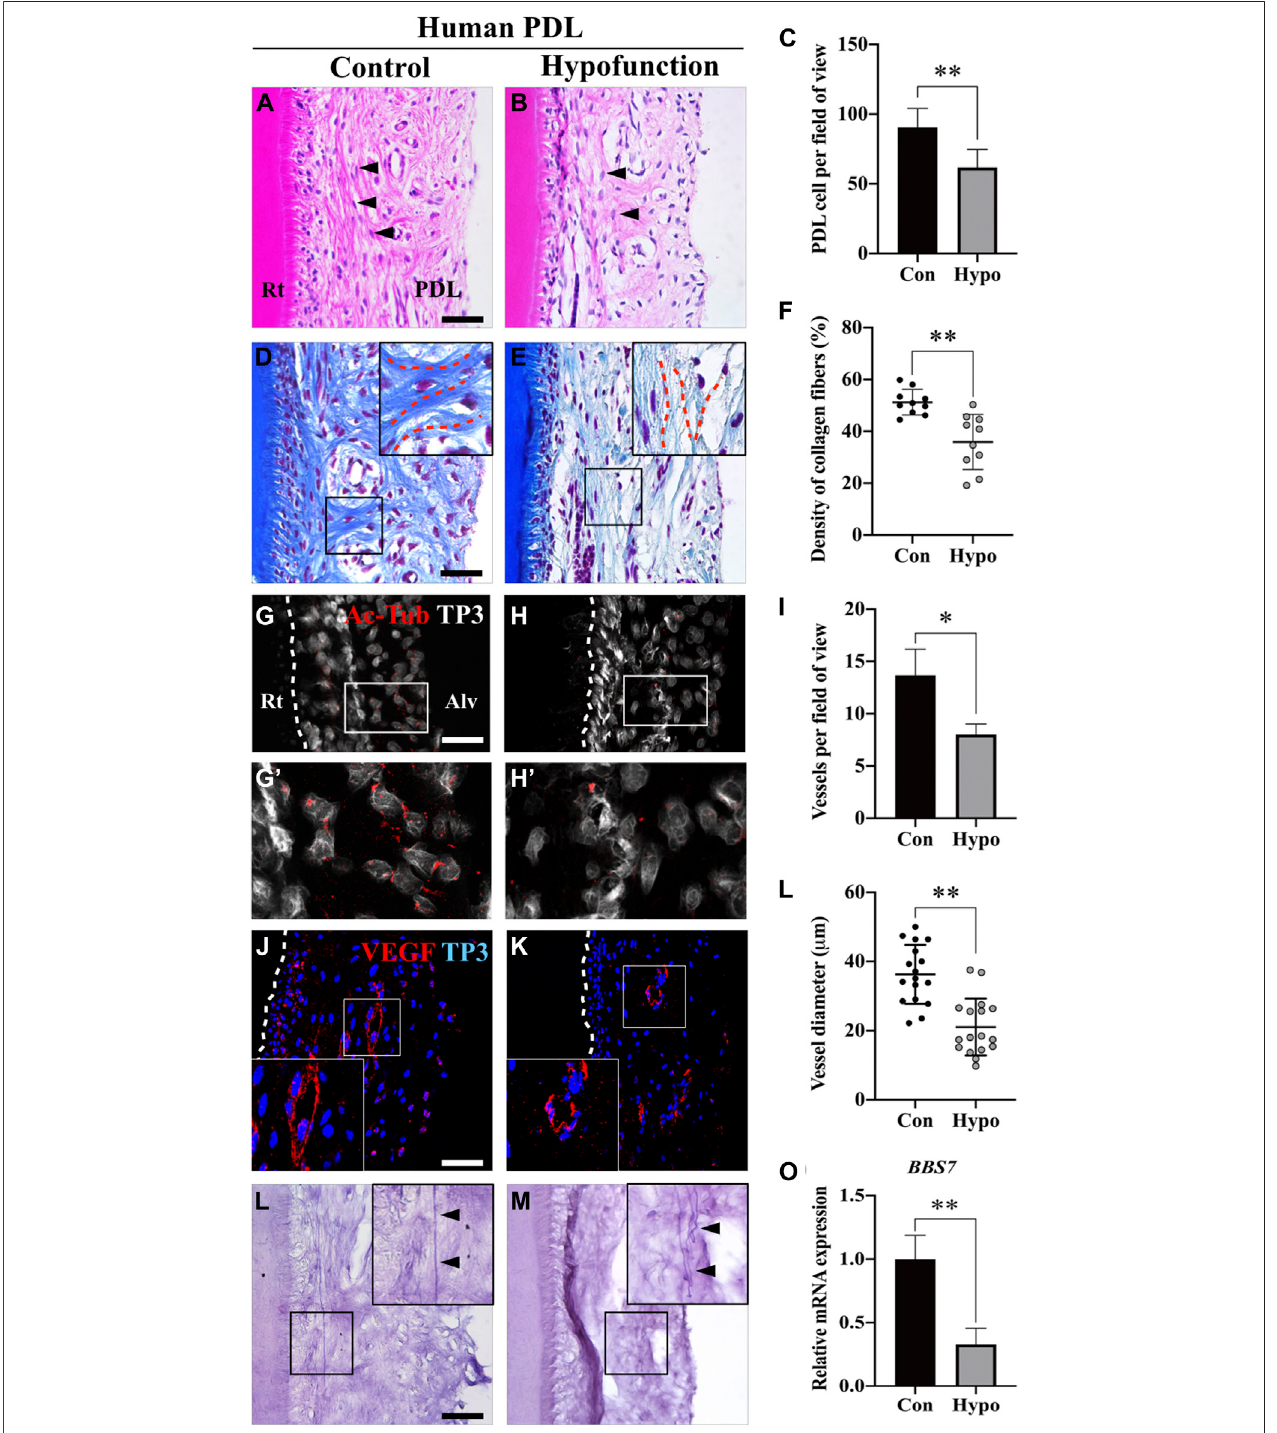
FIGURE 2 | Morphological changes of PDL in patients with occlusal hypofunction. (A,B) Hematoxylin and eosin staining of human PDL from the extracted tooth. The shape of fi broblasts (arrowheads) was changed from spindle (control) to round (hypofunction). (C) Quanti fi cation of PDL cell number in control and hypofunction groups ( n (cid:1) 5). (D,E) Masson ’ s trichrome staining showed disorientation of the type I collagen fi bers (blue) in the hypofunction group. The PDL fi bers aligned perpendicular to the root in the control group, whereas the relatively sparse fi bers were parallel to the root in the hypofunction group (red dotted line). (F) Quanti fi cation of type I collagen fi ber density in control and hypofunction groups. (G,H) Primary cilia were stained with Ac-Tub, and nuclei were stained with TP3. White dottedlineindicatedthemarginoftheroot.(G ′ )Ac-Tub – positivecellsinthecontrolgroupweregatheredalongthealveolarboneside(H ′ ),whereasitwasrarelyobserved